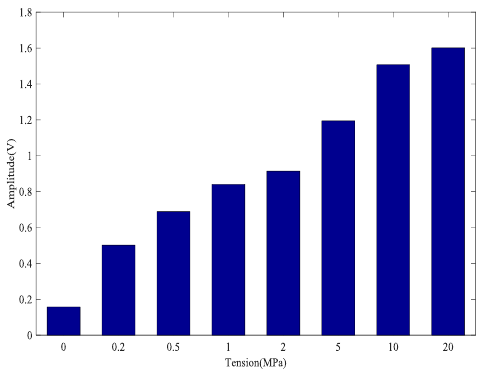
Figure 13. Magnitudes of focused signals based on times reversal for five repeated tests.